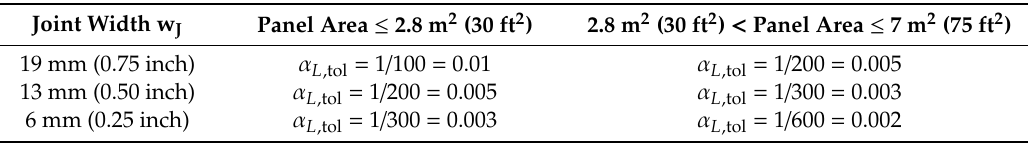
Figure 2. Definition of ( a ) longitudinal and ( b ) transversal angular distortions. Table 1. Tolerable longitudinal angular distortion ( α L ) values for MSE walls constructed with incremental precast concrete panels (modified from [6]).